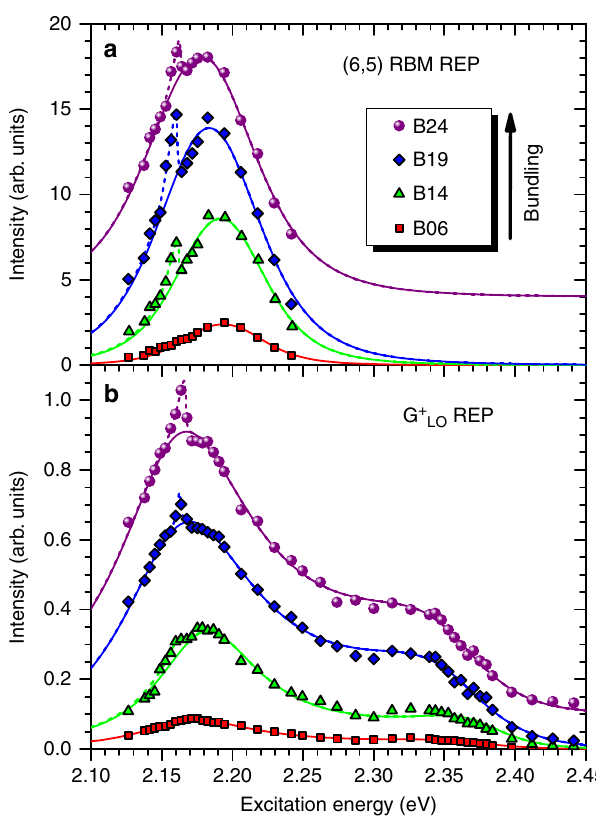
Fig. 2 Bundle-dependent appearance of sharp anomalous resonance peak in Raman excitation pro fi les of (6,5)-enriched SWCNTs. REPs of the a RBM and b G þ mode with increasing bundle size for SWCNT fractions labeled LO B06 to B24. Data shown as symbols, fi ts to a Lorentzian model (as described in text) shown as lines. A sharp additional feature at ~2.16 eV appears for bundled samples and increases with bundle size. In fi tting the REPs to Eq. (1), E ph was fi xed at the experimentally measured phonon frequencies. A dashed line is added over the anomalous peak (AP) feature as a guide to the eye. Curves for B24 offset vertically for clarity